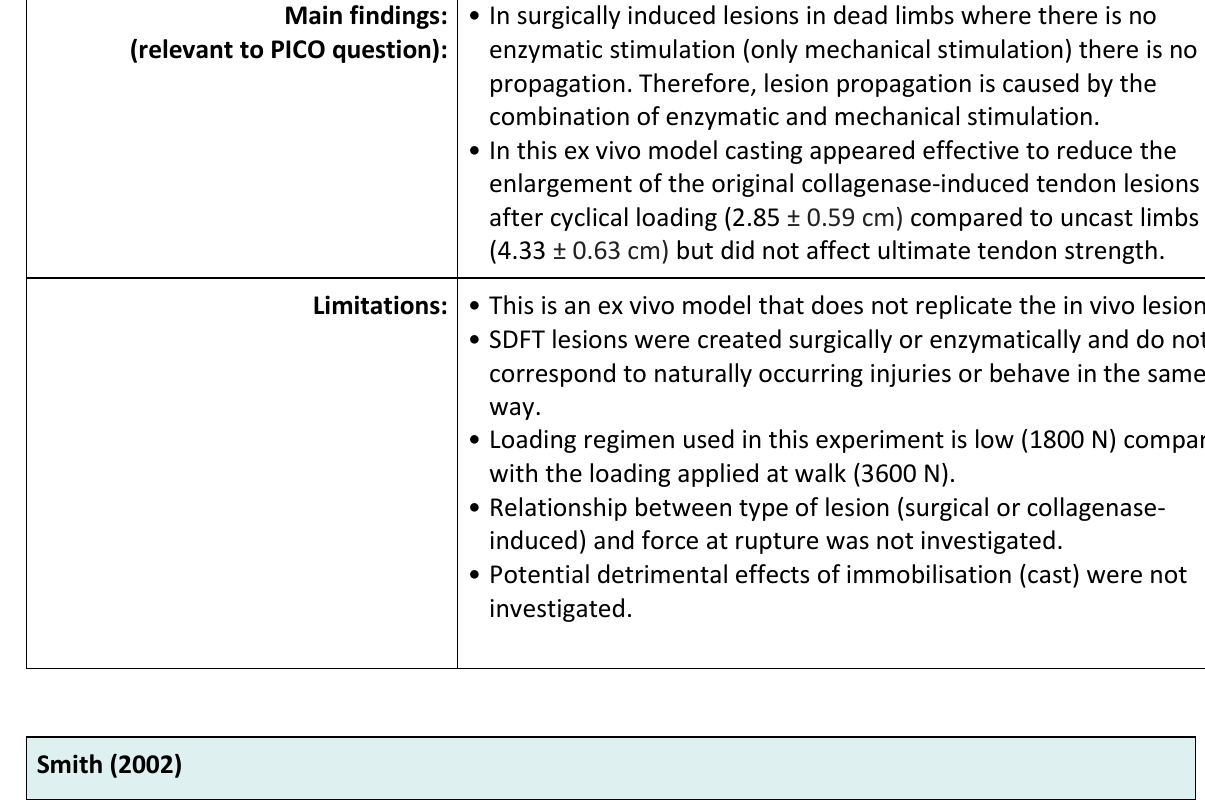
Population: Postmortem equine forelimbs from Thoroughbred type horses with no signs of distal limb